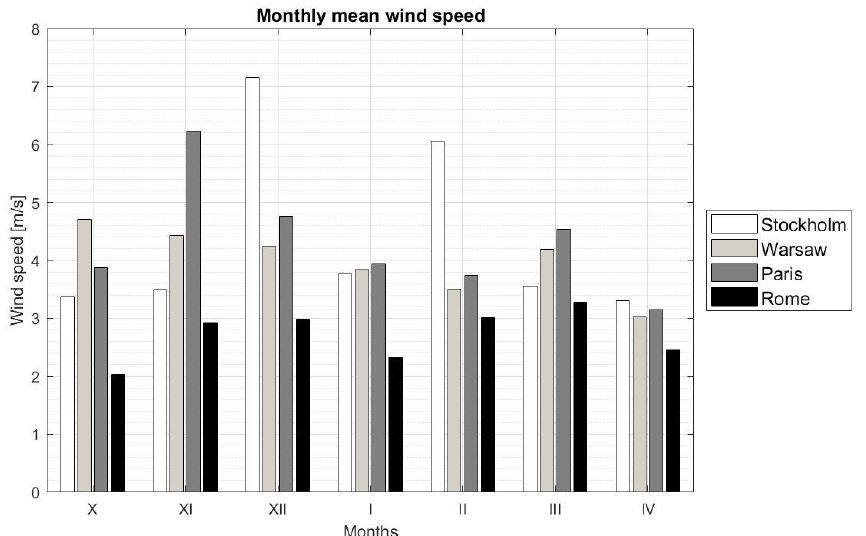
Figure 4. Monthly mean wind speed during the heating period (calculated on the basis of data from [44]).